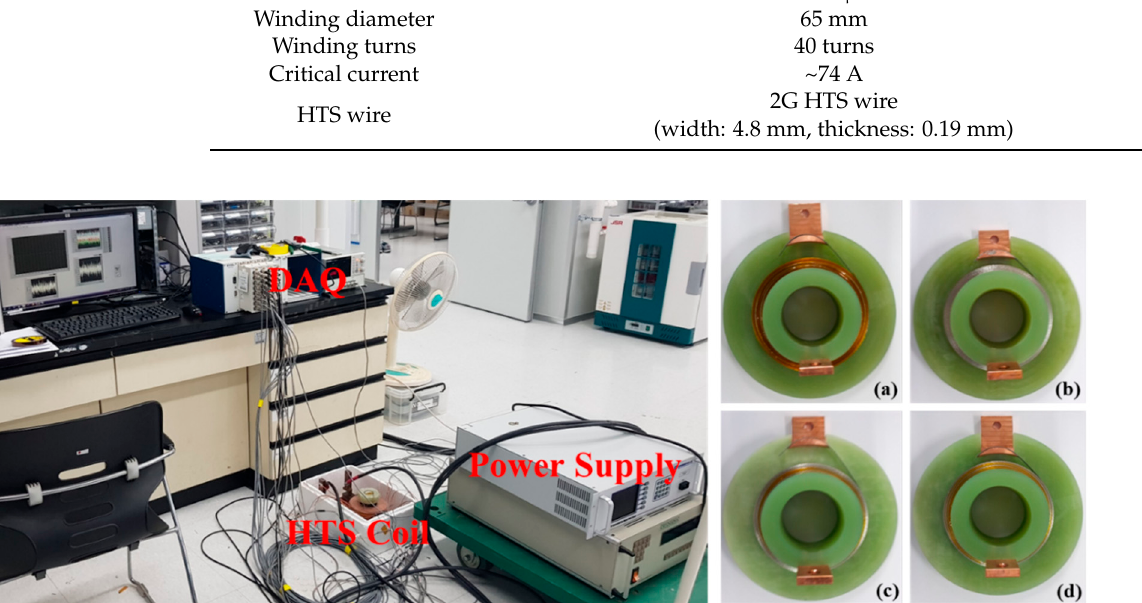
Figure 1. Experimental setup and HTS coils for charging/discharging tests: ( a ) Coil I, ( b ) Coil II, ( c ) Coil III, and ( d ) Coil IV.